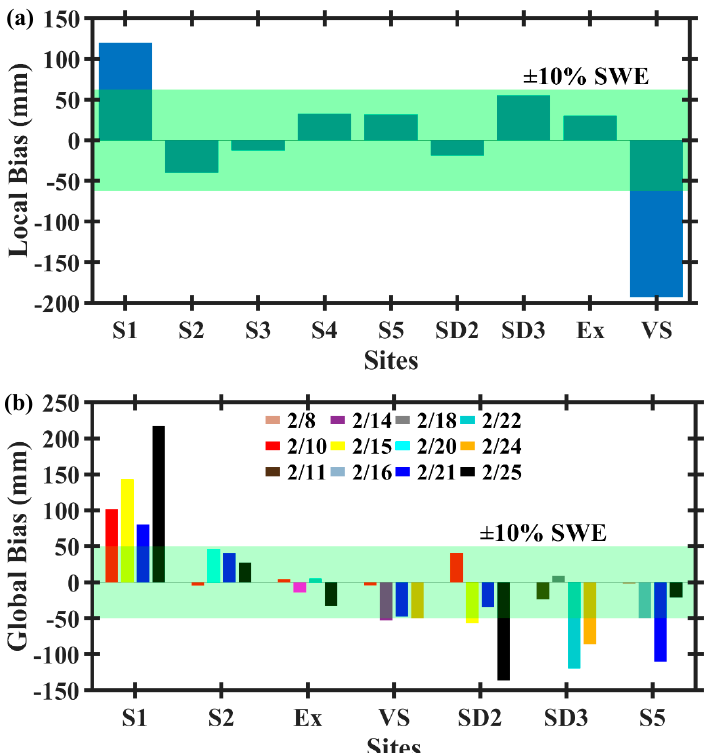
Figure 5. Evaluation of model bias at reference ECMWF grid points (Figure 1) during SnowEx’17 (Table S1). ( a ) Local bias calculated as the difference between the Ensemble 5 Member corresponding to the nearest HRRR grid and the average of SnowEx’17 snowpit measurements within each ECMWF reference grid point for the entire month of February. ( b ) Global bias is calculated as the difference between the Grand Mesa Ensemble 5 mean and the average snowpit measurements on the same day within each ECMWF reference grid point.